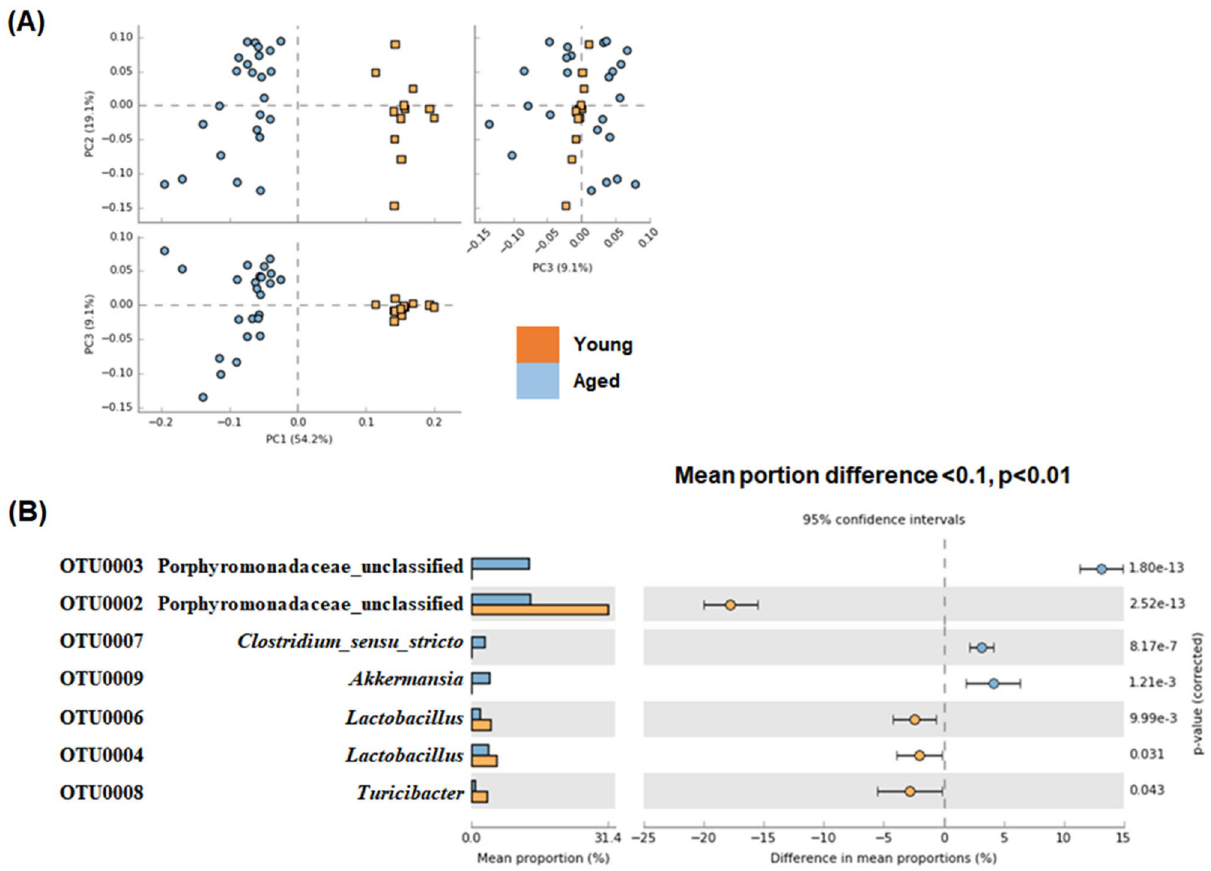
Figure 3. Comparison of gut microbiota between young mice (Young Groups at 8 weeks) and aged mice (Aged Groups at 100 weeks) based on principal component analysis ( A ) and operational taxonomic units (OTUs) with significantly different abundance ( B ). Corrected P values are shown on the right. The effect sizes and confidence intervals are provided to allow for critical assessment of the biological relevancy of the test